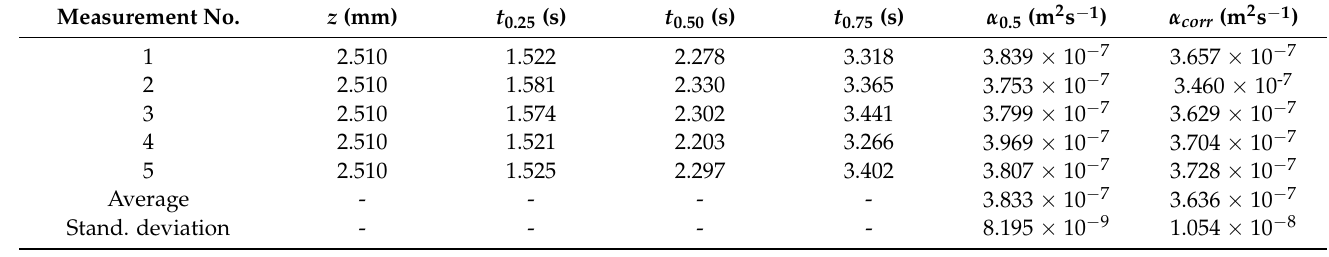
Table 3. Thermal diffusivity—TeXtreme ® 100.